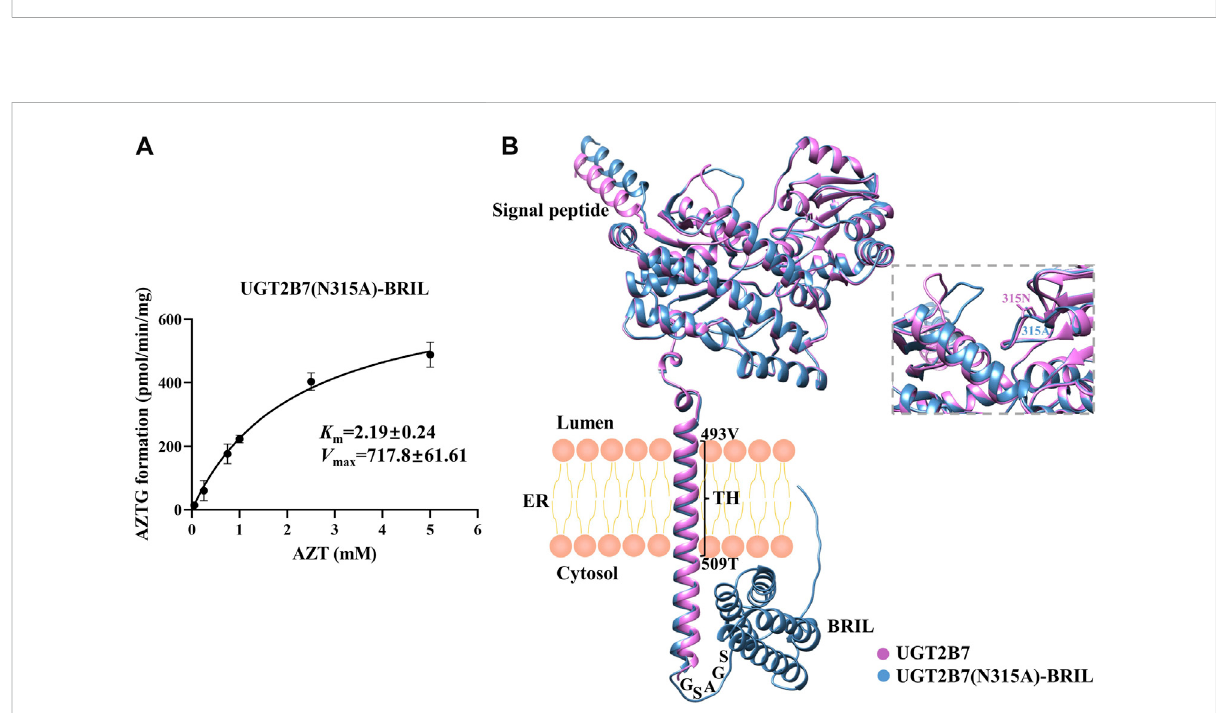
FIGURE 5 (A) Enzyme kinetics of AZTG formation of UGT2B7(N315A)-BRIL. Samples were analyzed by LC-MS/MS as described under Materials and Methods. AZT concentrations versus AZTG formation rates are shown. Glucuronidation rates are the mean ± standard deviation of three independent determinations. (B) Aligned three-dimensional structures of the UGT2B7 (pink) and UGT2B7(N315A)-BRIL (blue). The enlarged image highlighted the two side chains at the position 315. The numbers represent the residue positions of the wide-type UGT2B7 counted from the N-terminus. TH, transmembrane helix; ER, endoplasmic